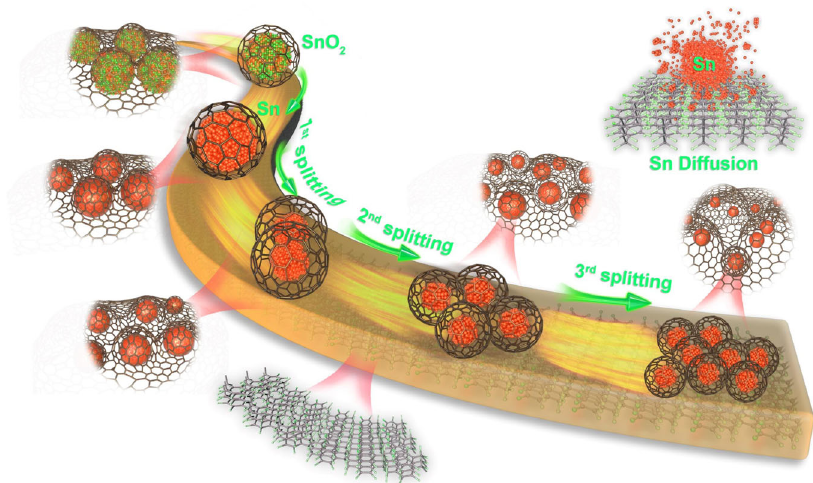
Fig. 1 Illustration the procedure of Sn splitting in the carbon matrix. As a result of the cycled annealing treatment, the inserted metallic Sn nanoparticles exhibited a biological cell-like behavior and split into nanoparticles with smaller sizes. Additionally, the phase transitions from α -Sn to β -Sn and from amorphous carbon to graphitic carbon